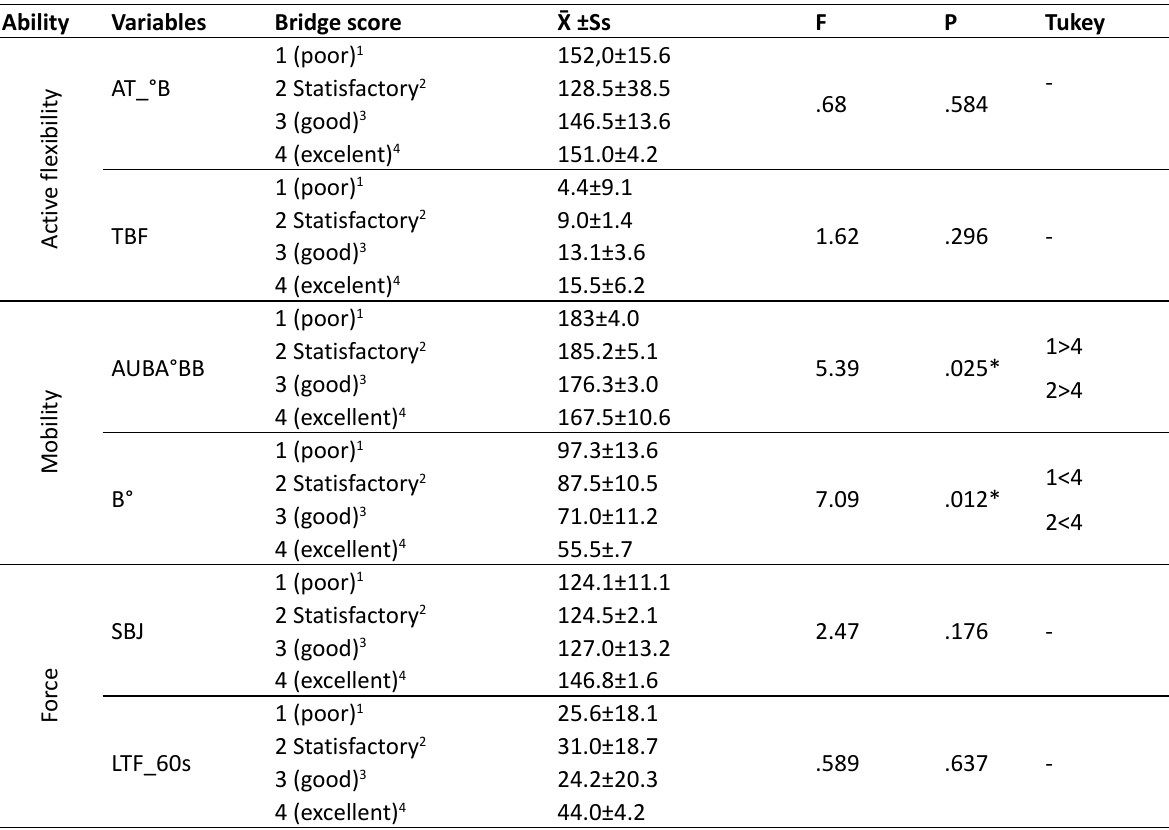
Table 5. Differences between flexibility, mobility and force tests to the bridge technique in artistic gymnastics